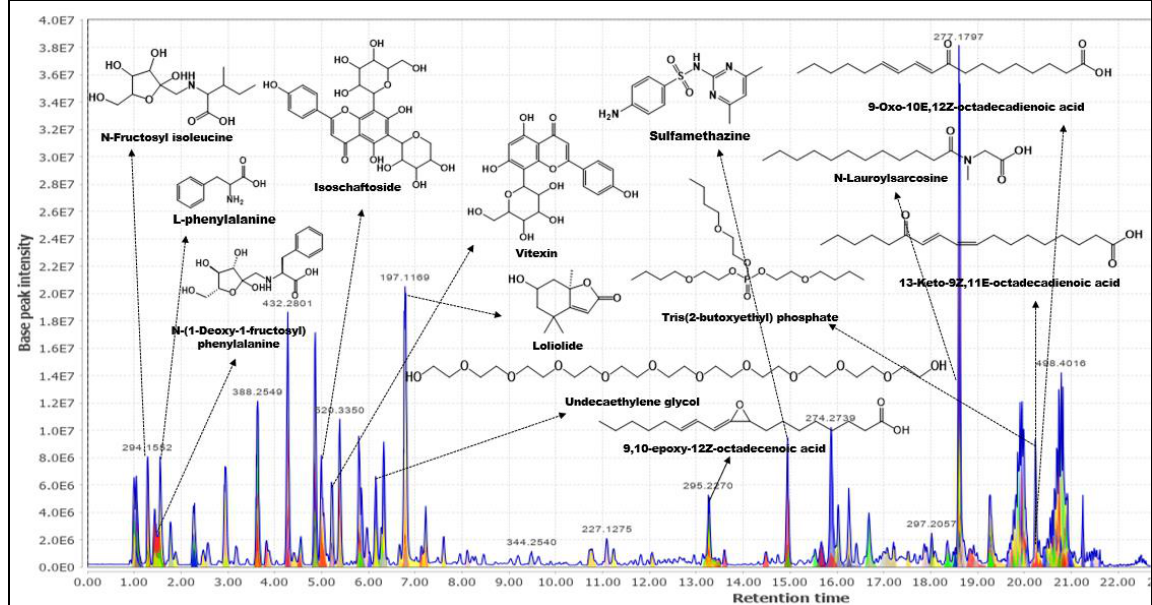
Figure 3. Annotated metabolites from GNPS based on TIC.